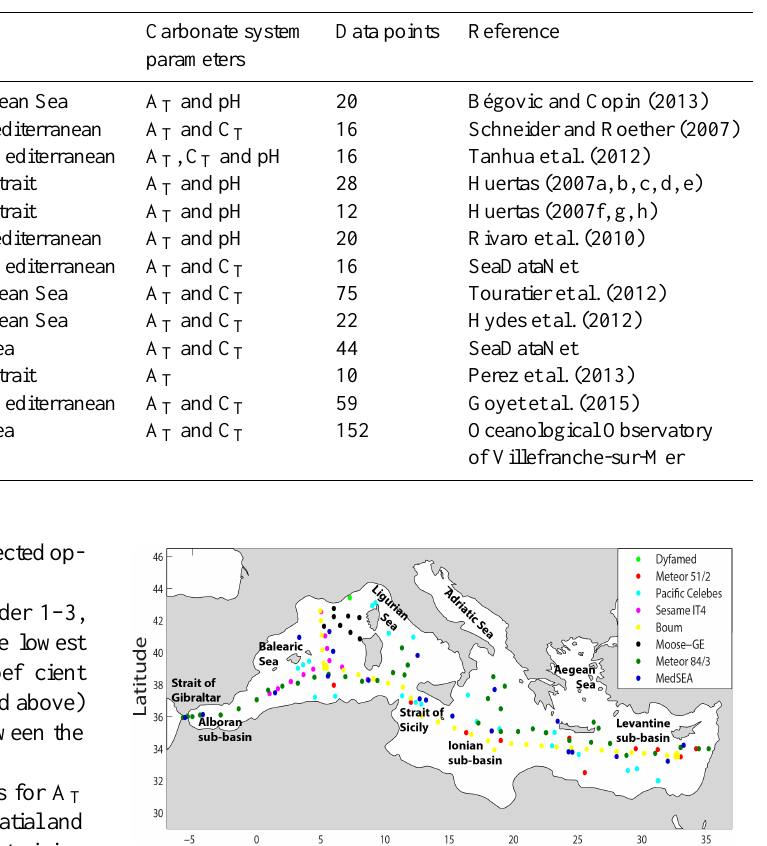
Table 1. List of available carbonate system datasets for the Mediterranean Sea.